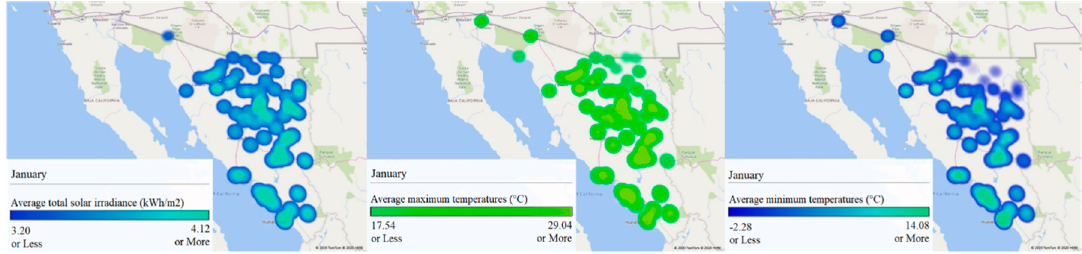
Figure 7. GIS analysis of Sonora for January: ( left ) average total solar irradiance (kWh/m 2 ), ( center ) maximum average temperatures (°C), and ( right ) minimum average temperatures (°C).